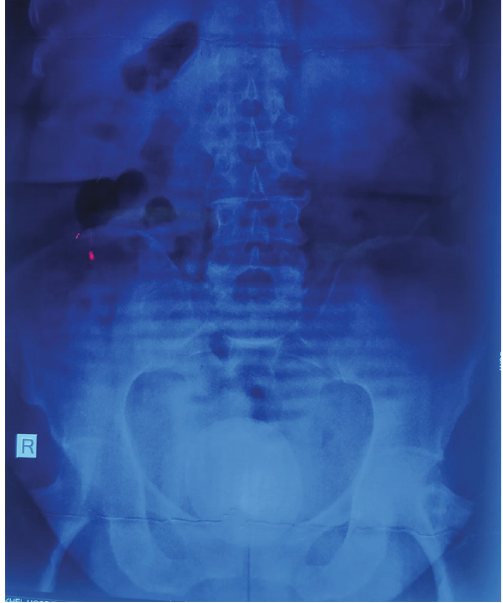
Figure 1: X-ray pelvis with bladder stone.